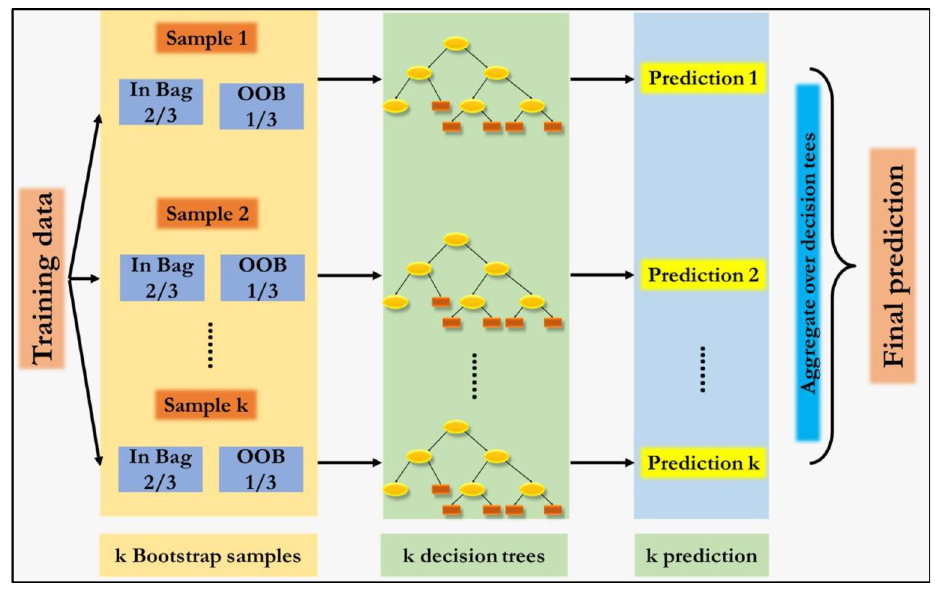
Fig 3. The schematic representation of RF.